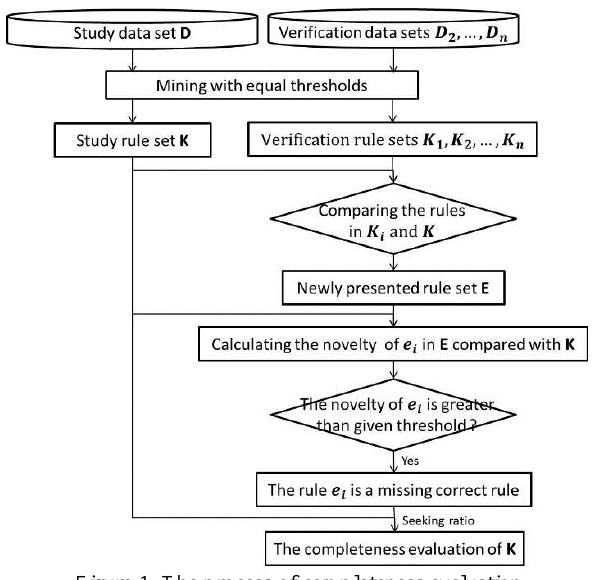
Figure 1. The process of completeness